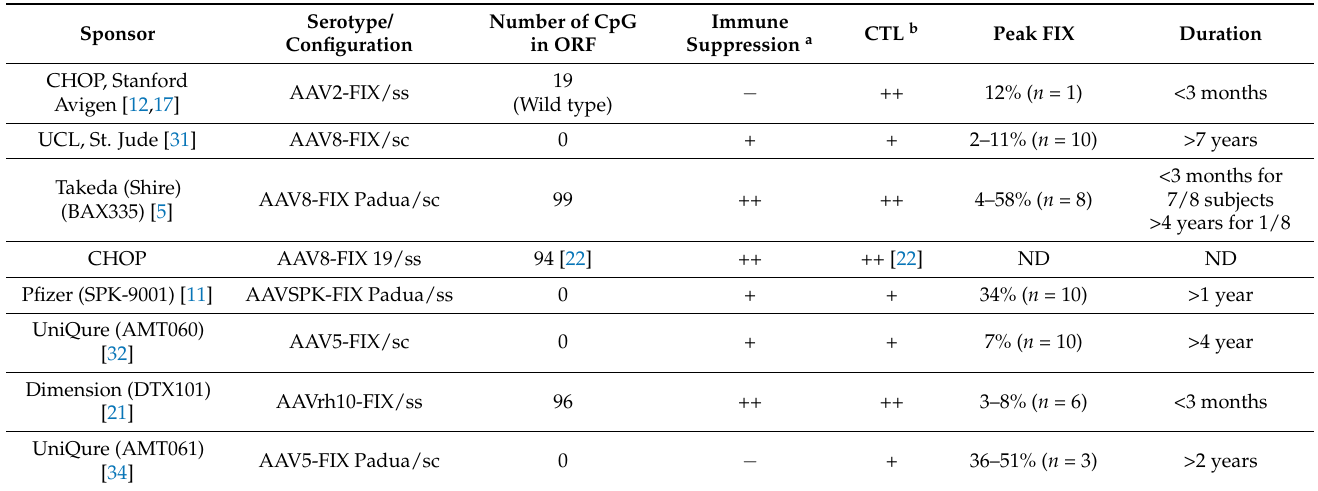
Table 2. Examples of AAV gene transfer clinical trials for hemophilia